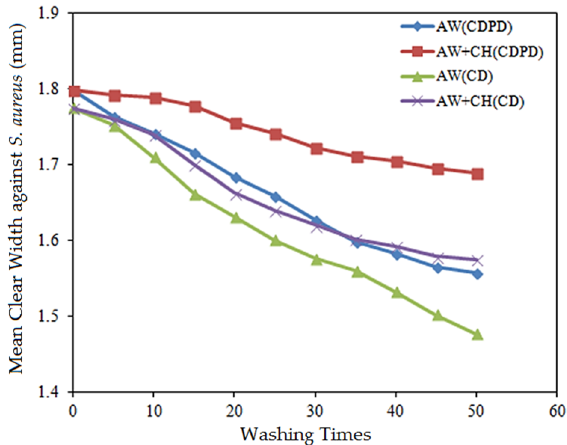
Figure 6. Antimicrobial effect of fabric finished with pad-dry-plasma-cure (CDPD) and pad-dry-cure (CD) processes before washing, after washing (AW), and after re-chlorination (AW + CH).